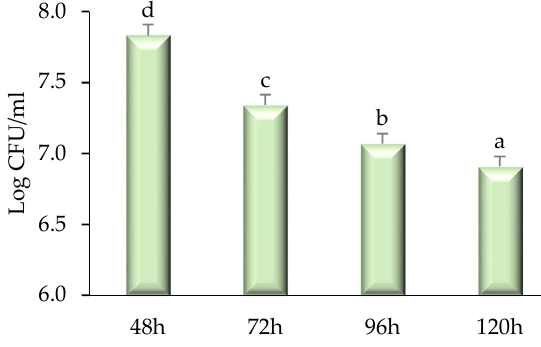
Figure 5. Time-kill kinetics of Citrus nobilis peel dry extract against the growth of pathogenic Candida albicans during different time intervals. Data are presented as means ± SEM ( n = 3); a–d: Means within the column with different lowercase superscripts are significantly different ( p < 0.05)